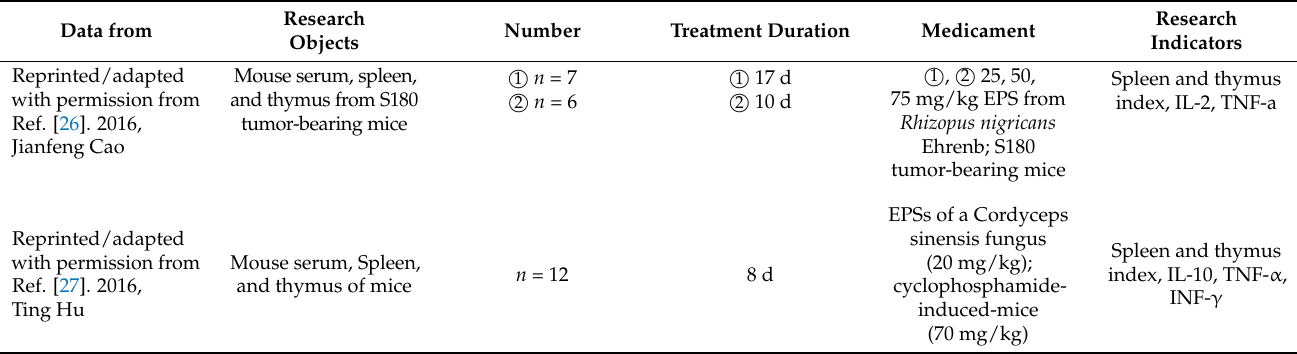
Figure 1. Preferred Reporting Items for Systematic Reviews and Meta-analyses (PRISMA) flow diagram of study selection. Table 2. Main characteristics of eligible